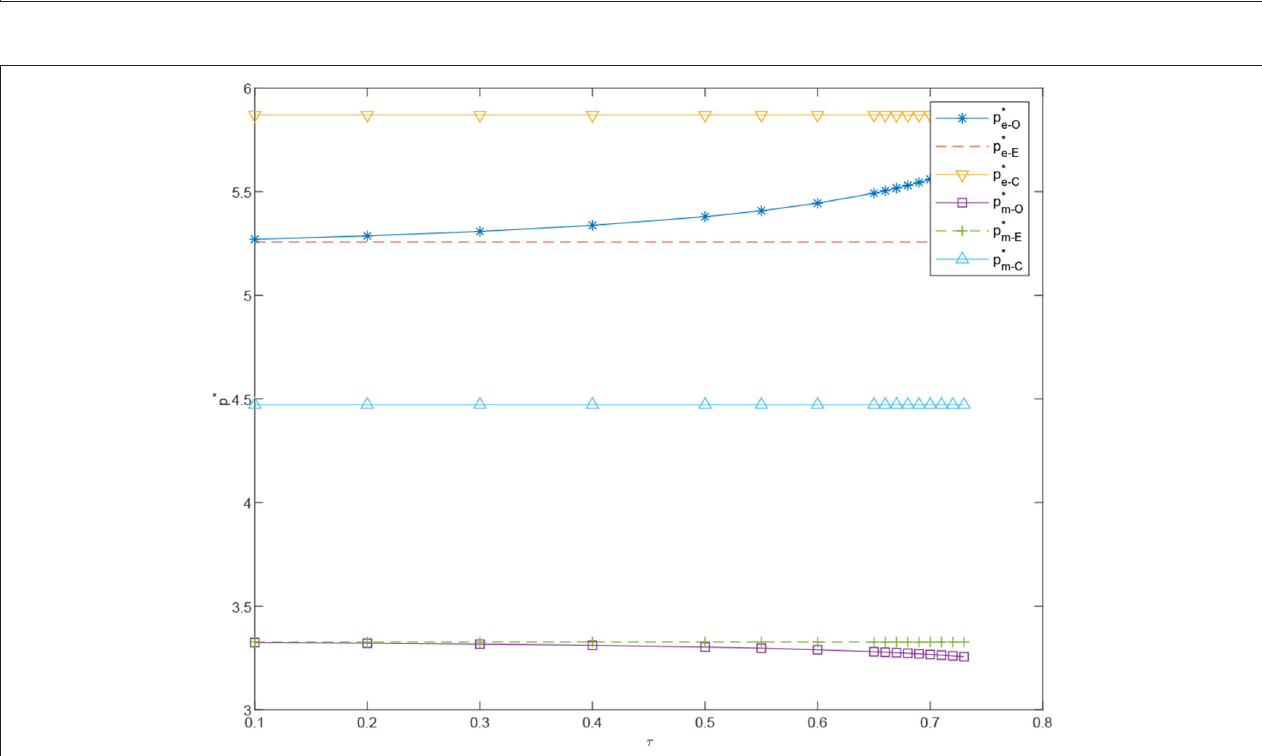
FIGURE 10 | The effect of τ on the prices, p ∗ e − O , p ∗ e − E , p ∗ e − C , p ∗ m − O , p ∗ m − E , p ∗ m − C .